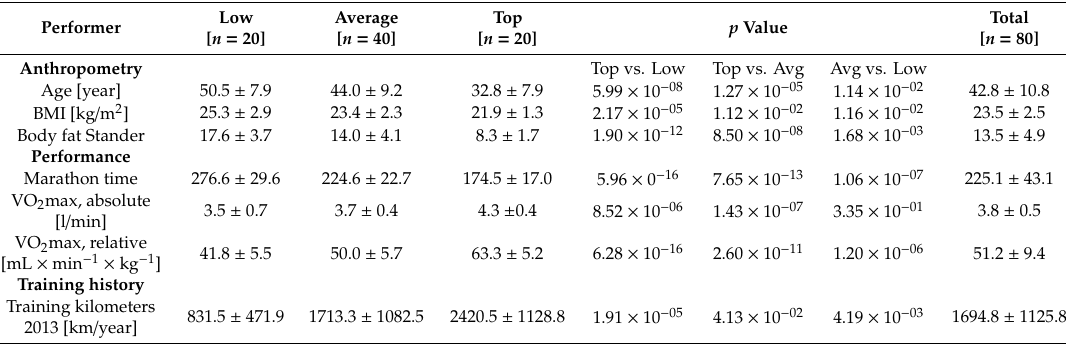
Figure 1. Performer selection plot. Stratification of the cohort based on the quotient between relative VO 2 max and running time. Athletes were categorized into 20 top (blue), 40 average (green), and 20 low (red) performers. Table 1. Baseline characteristics of the study participants.